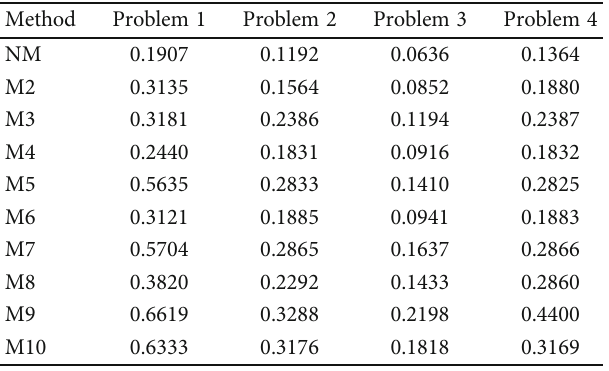
Table 2: Values of CR2 for methods 1-10 to solve all test problems, and n = 100 .